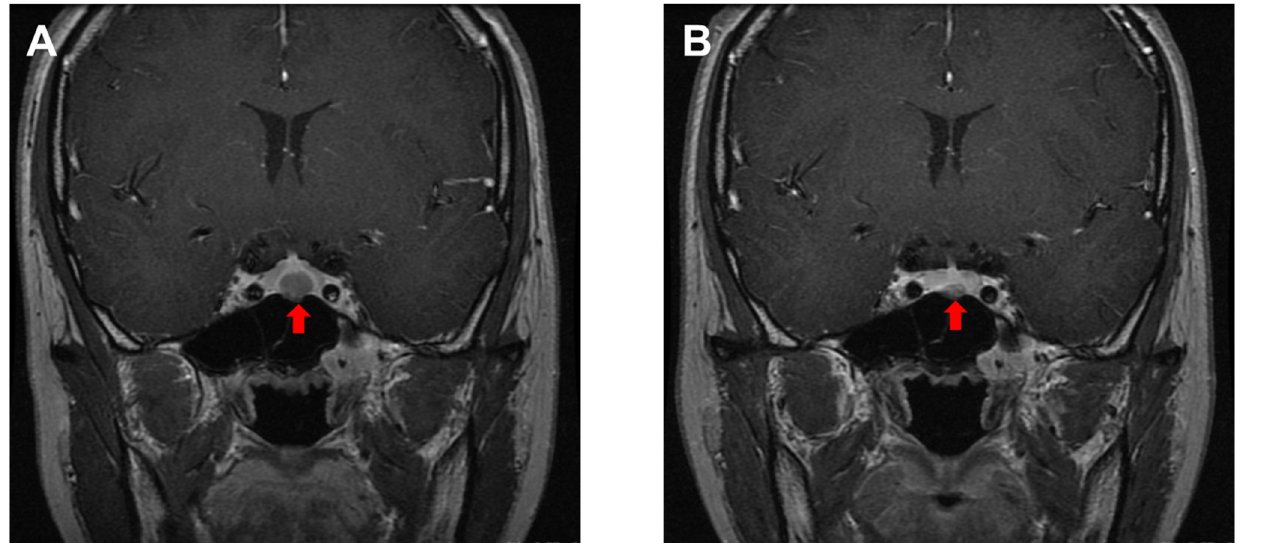
Figure 1. A representative case of enhanced T1-weighted MRI findings of prolactinoma. A 17-year- old woman presented with galactorrhea and amenorrhea. Serum prolactin (PRL) was 407 ng/mL, and gadolinium-enhanced MRI showed a pituitary mass lesion (arrow, A ). The patient was diagnosed with prolactinoma, and cabergoline (0.25 mg per week) was prescribed and then increased (0.5 mg per week). Two years later, serum PRL was 15 ng/mL, and the MRI scan revealed that the pituitary microtumor had shrunk (arrow, B ).